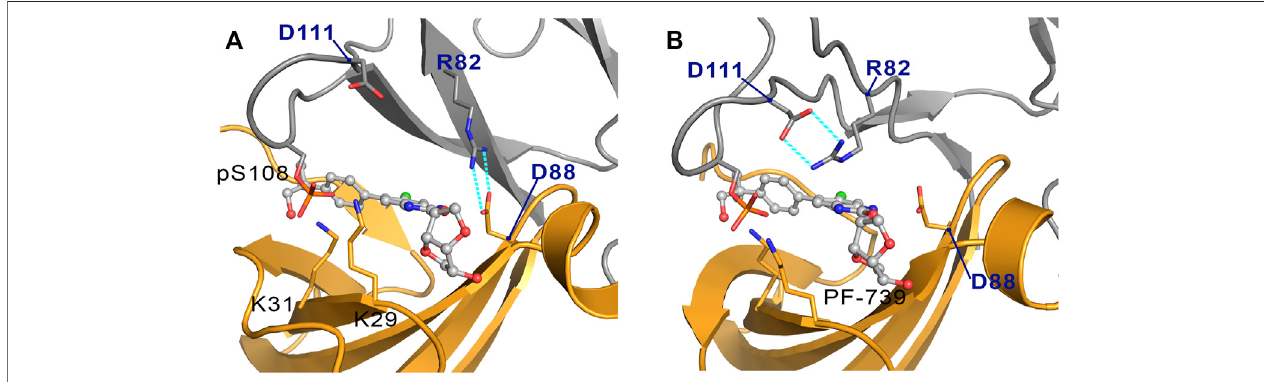
FIGURE 9 | Representation of the two orientations of the β 2-Arg82 in α 2 β 2 species, where the interaction with (A) the α 2-Asp88 and (B) the β 2-Asp111 are highlighted in cyan dashed lines. The α -subunit is shown in orange cartoon, while the β -subunit is shown in grey cartoons. PF-739 is shown in grey ball and sticks in the ADaM site.